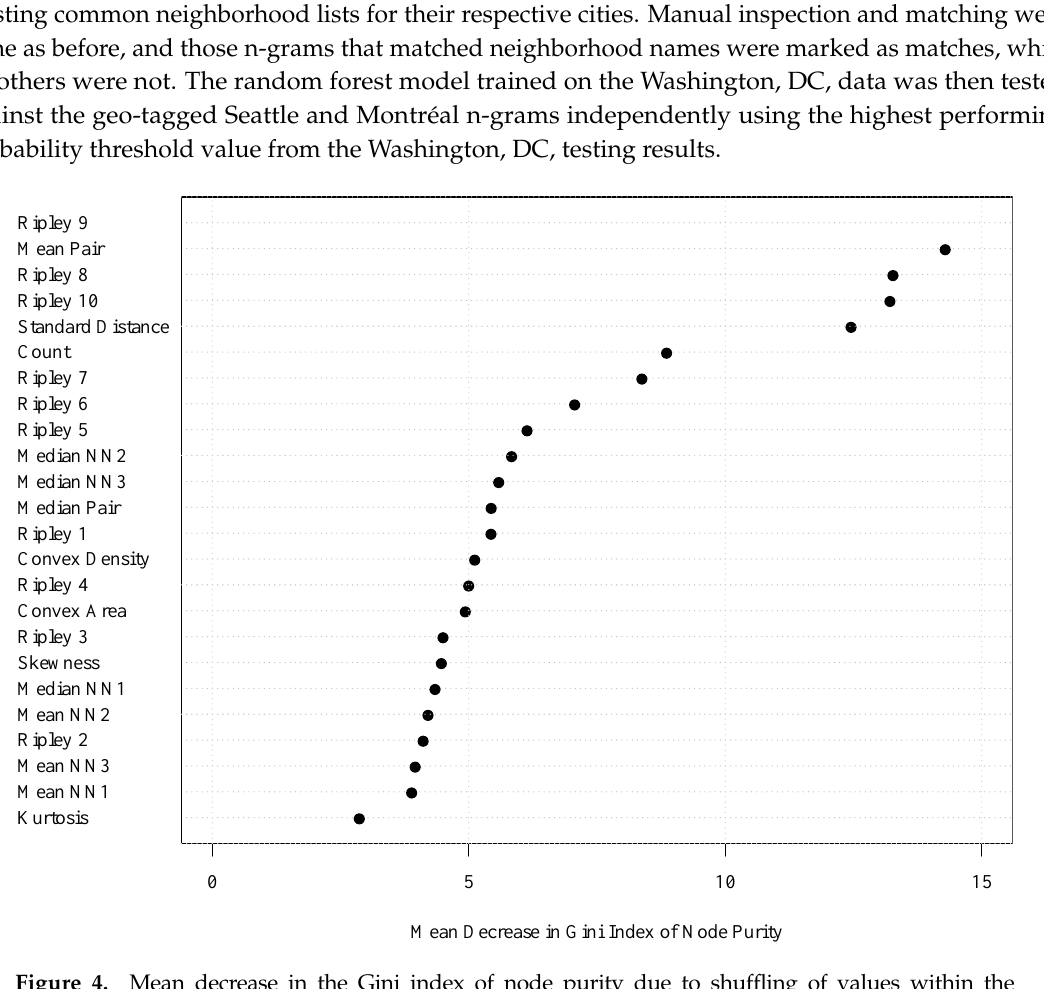
Figure 4. Mean decrease in the Gini index of node purity due to shuffling of values within the predictive variable. NN, n-gram